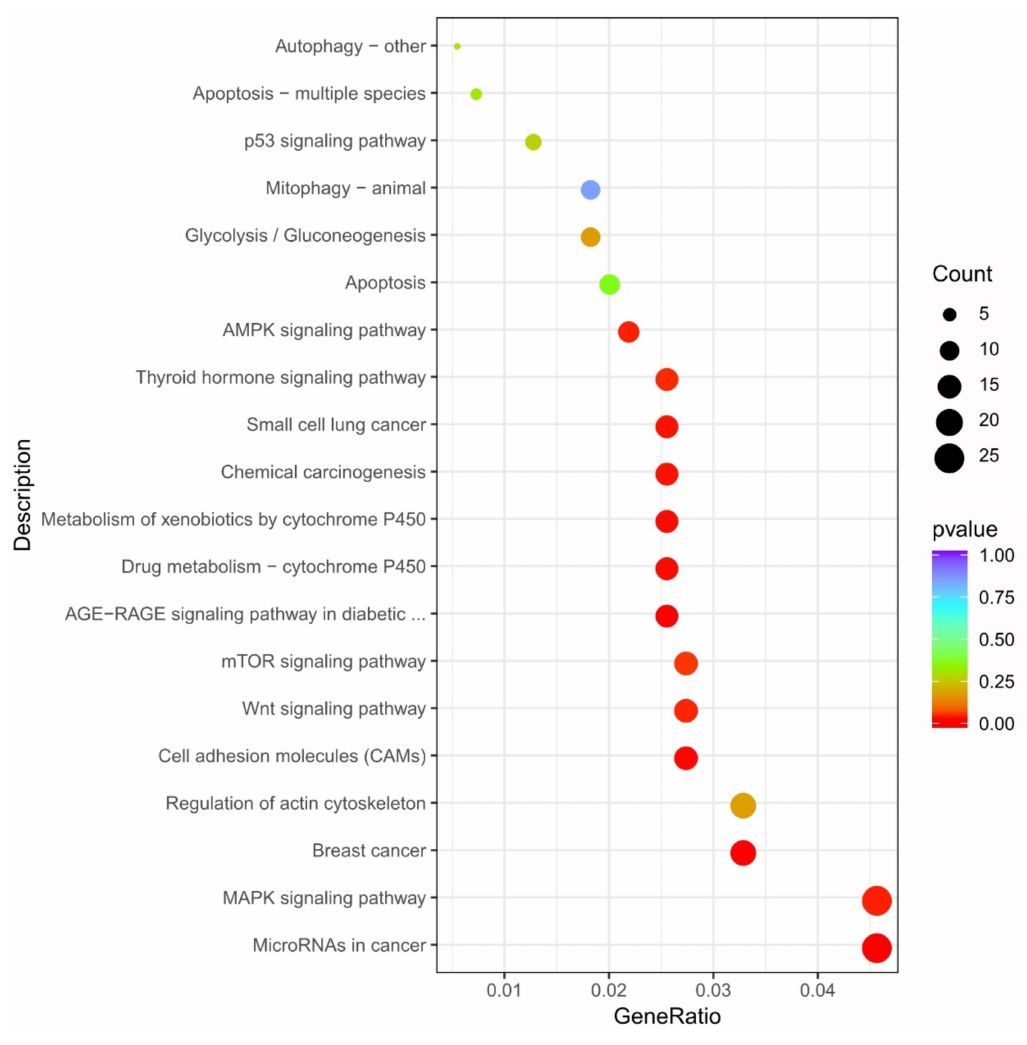
Figure 11. KEGG enrichment analysis of DEGs after BUP